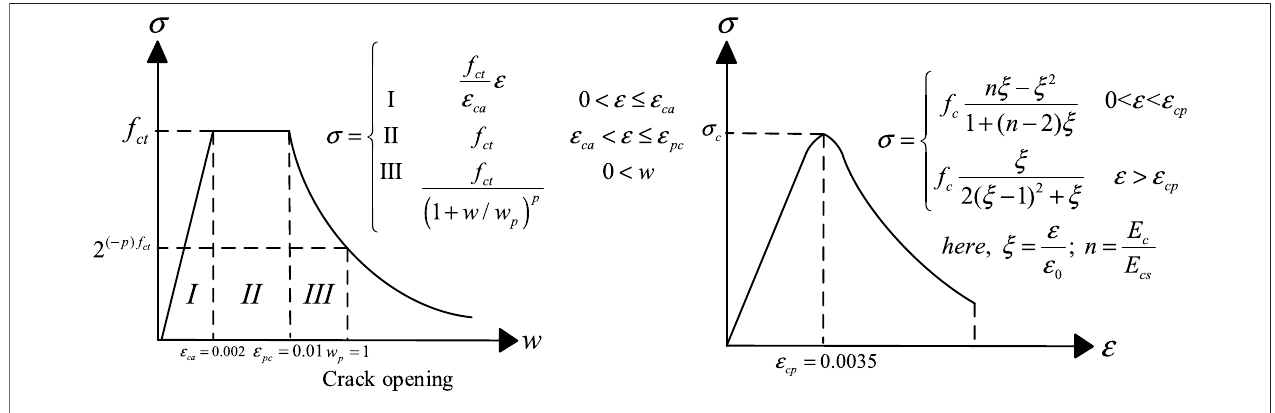
FIGURE 3 | Constitutive law of UHPC under (A) tension and (B)